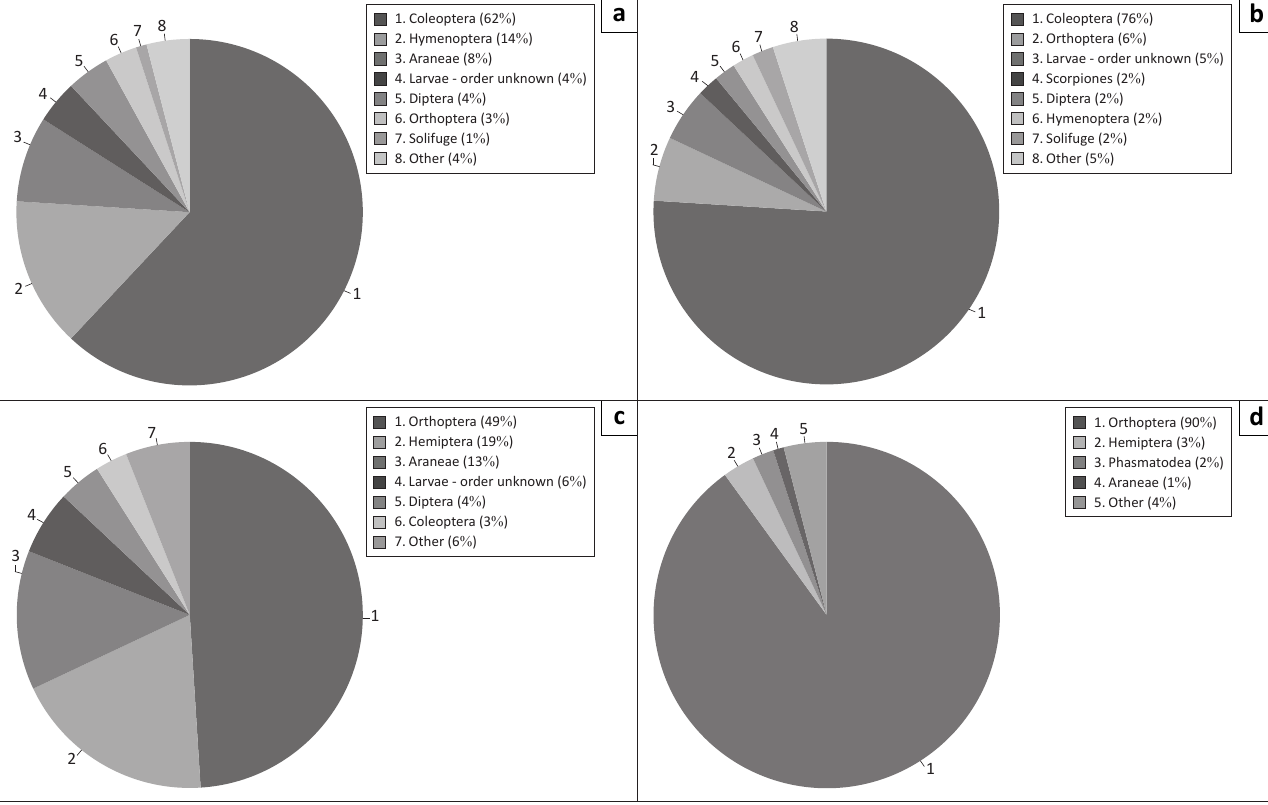
FIGURE 3: Comparison of the number and volume (determined using the volumetric water displacement method) of invertebrate orders captured by pitfall and sweep net sampling at four sites and expressed as a percentage according to, (a) numbers of invertebrates from pitfall traps categorised per order, (b) volume of invertebrates from pitfall traps categorised per order, (c) numbers of invertebrates from sweep nets categorised per order and (d) volume of invertebrates from sweep nets categorised per